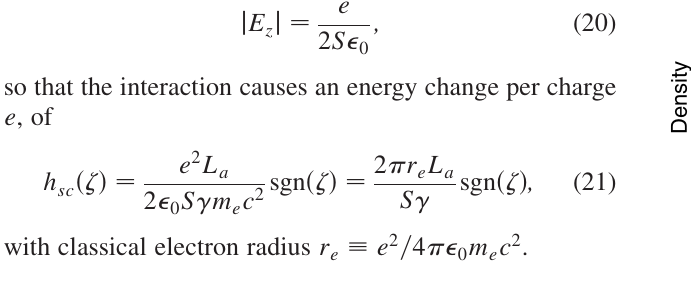
FIG. 4. On the left we show a histogram of particle density for particles loaded with random longitudinal positions. At right,